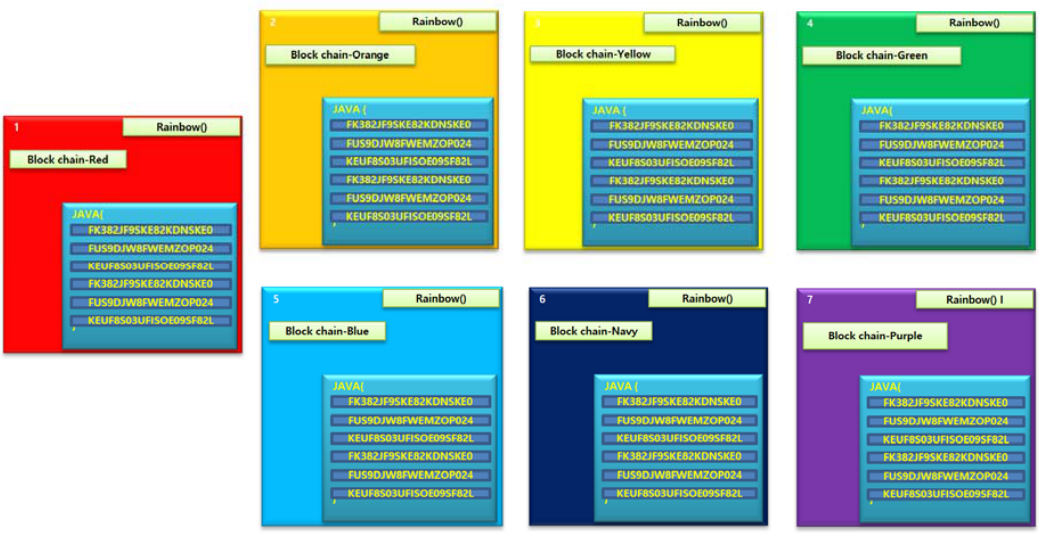
Figure 4. Rainbowchain architecture.